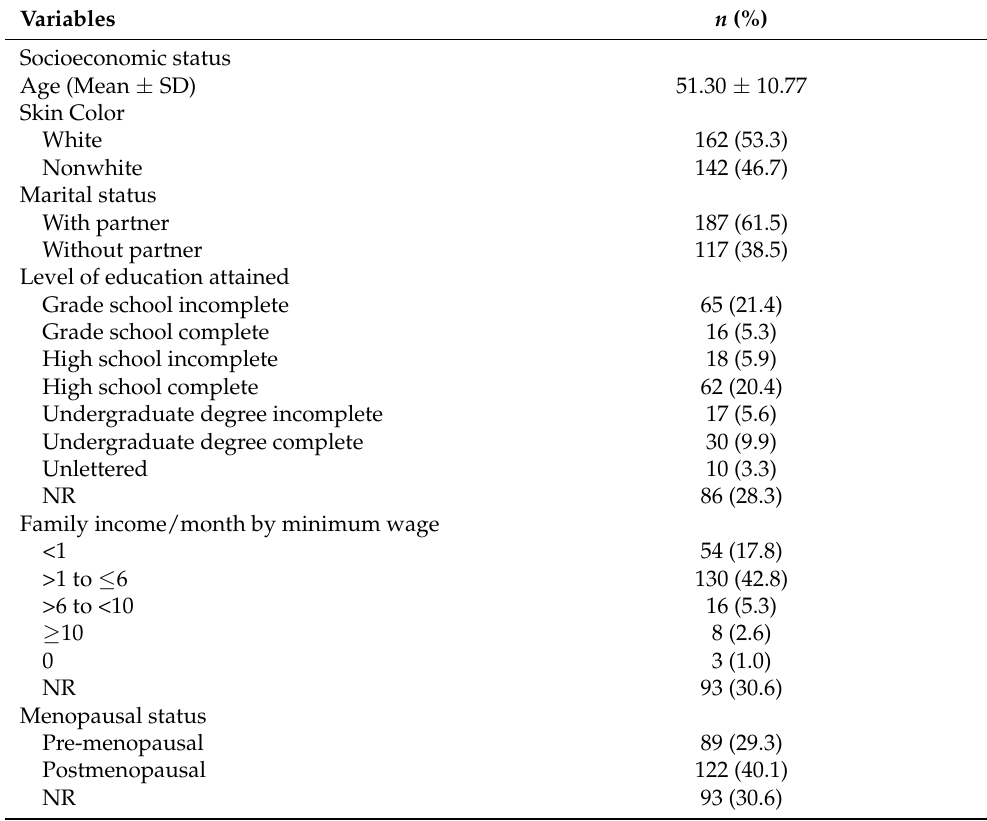
Table 1. Socioeconomic status characteristics of breast cancer women undergoing CT ( n = 304), Brazil, 2004–2018.